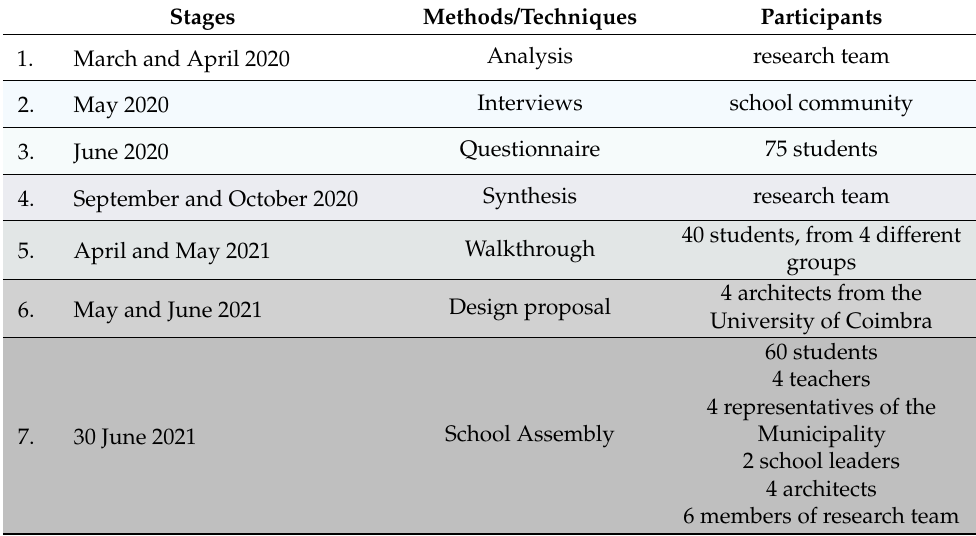
Table 3. Sequential development of the implementation of S3S in the pilot study. Stages